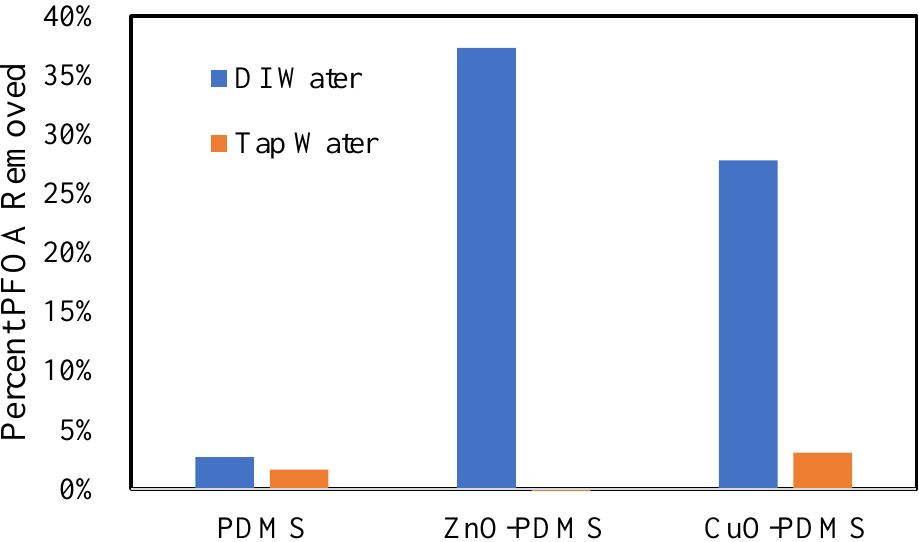
Figure 8. PFOA removed by membrane samples from aqueous solutions of PFOA after 3 days. Mass of membrane samples = 0.1 g. Initial PFOA concentration = 1000 mg/L. Solution volume = 20 mL.